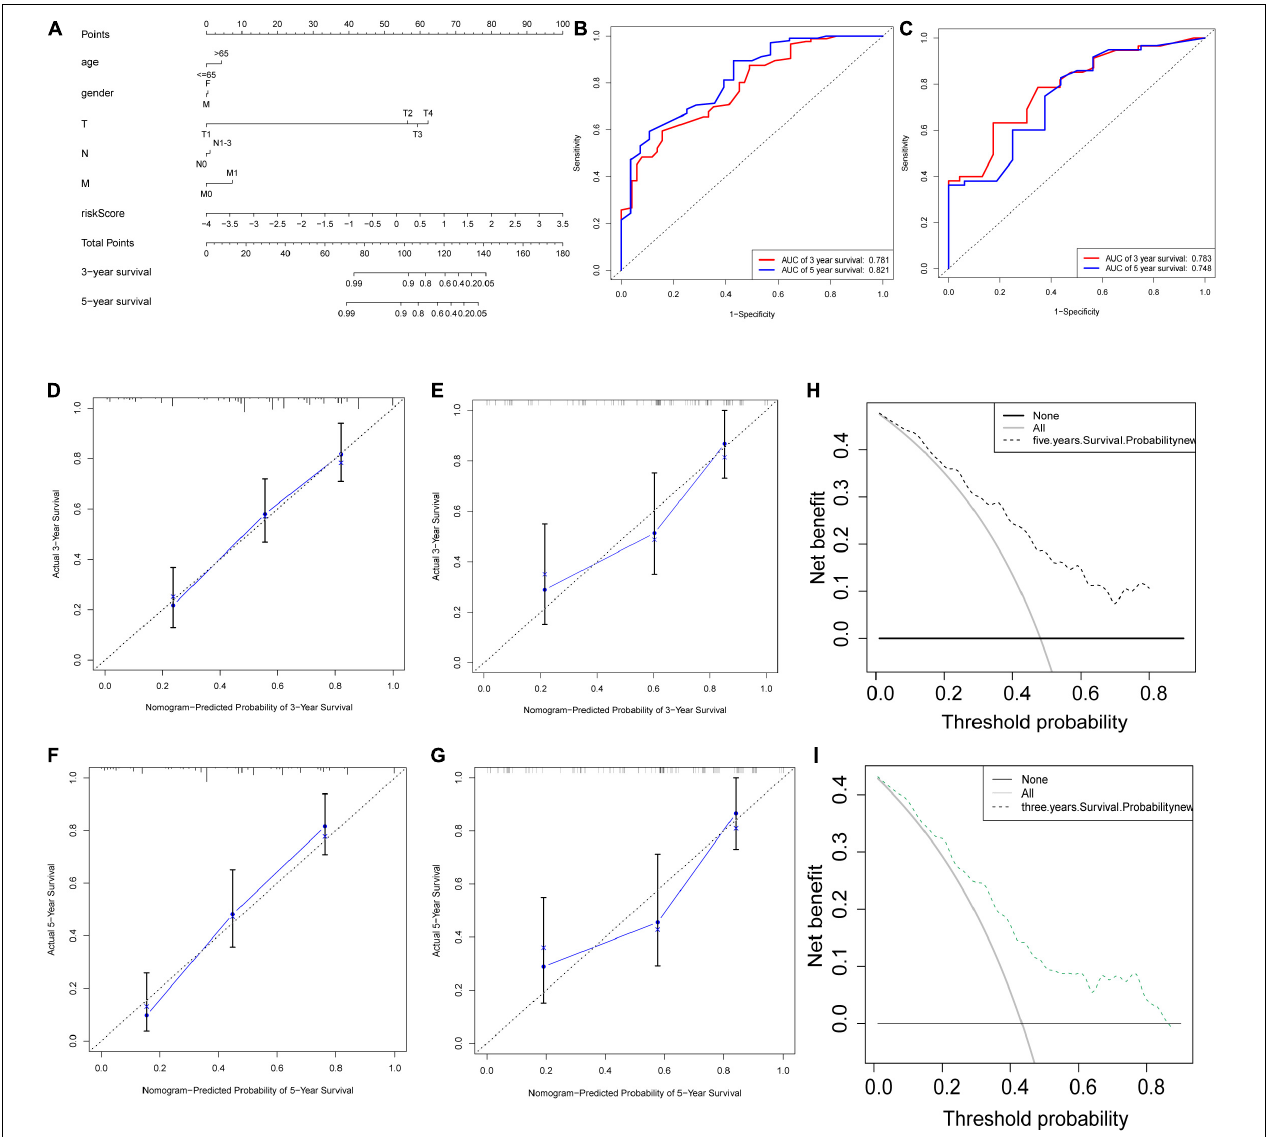
FIGURE 5 | Establishment and evaluation of the nomogram. (A) Nomogram for predicting the 3-year and 5-year survival rates of bladder cancer patients. (B,C) ROC curve analysis results showed that the AUC of the training set (B) for 3-year OS and 5-year OS were 0.781 and 0.821, respectively, and those in the validation set (C) were 0.783 and 0.748, respectively. (D–G) The calibration curves for the 3-year and 5-year OS of the nomogram in the training set (D,F) and validation set (E,G) . (H,I) The clinical decision curve for the 3-year OS (H) and 5-year OS (I) of the